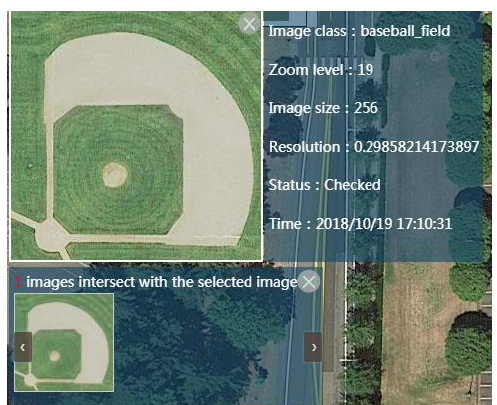
Figure 5. Interface of details of labelled images